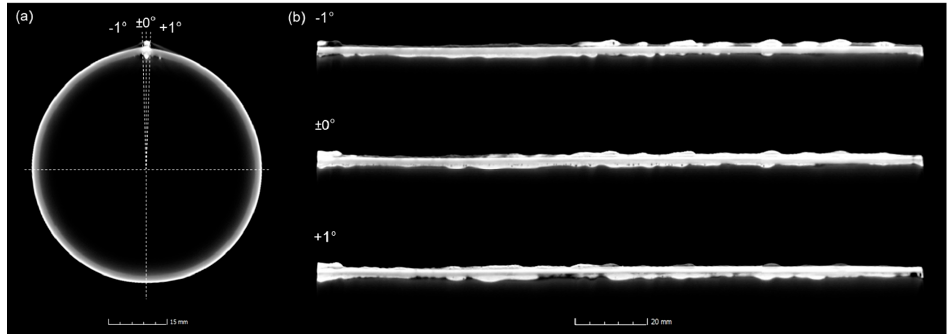
Figure 4. Computer Tomography (CT) scan of the welded tube with ( a ) front view on weld seam and ( b ) longitudinal view on weld seam.